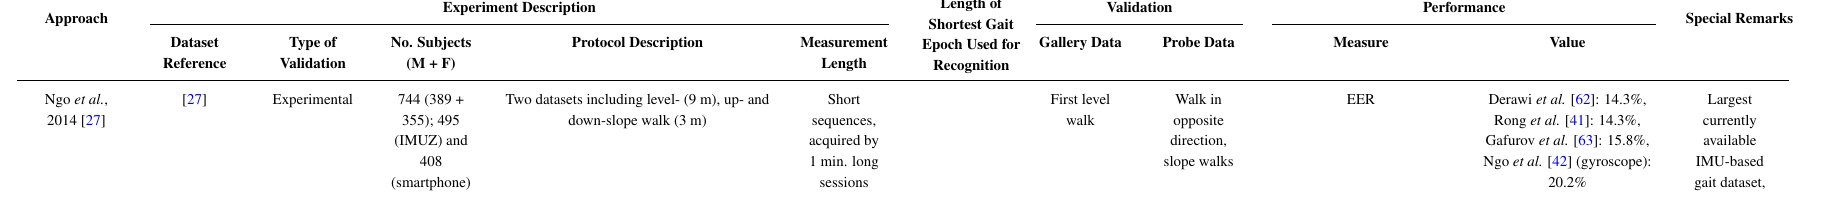
Table 3. Evaluation of representative inertial sensor-based gait recognition approaches (part